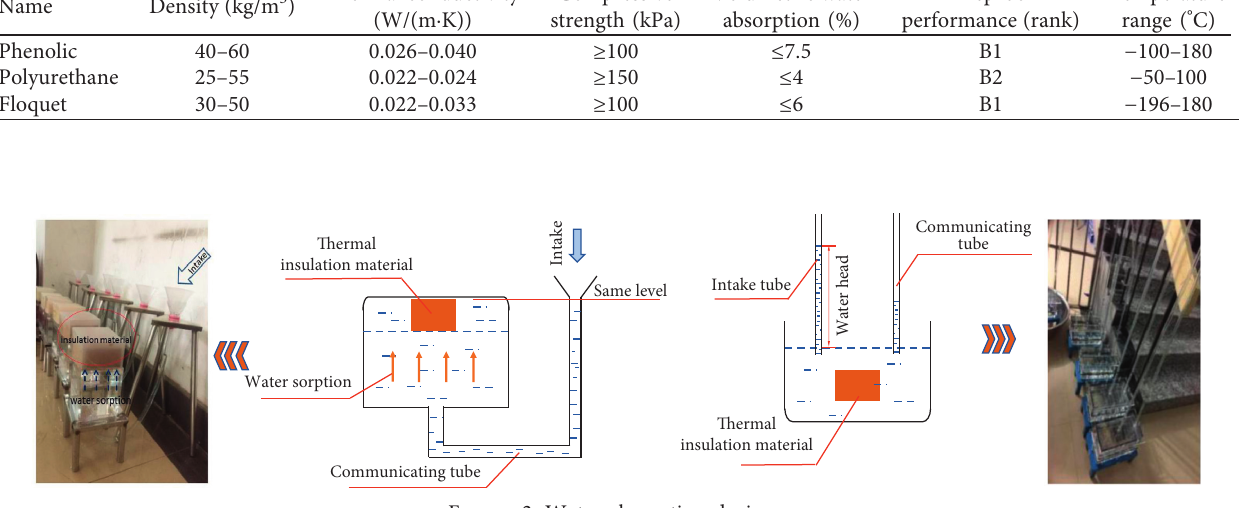
Figure 2: Water absorption devices.